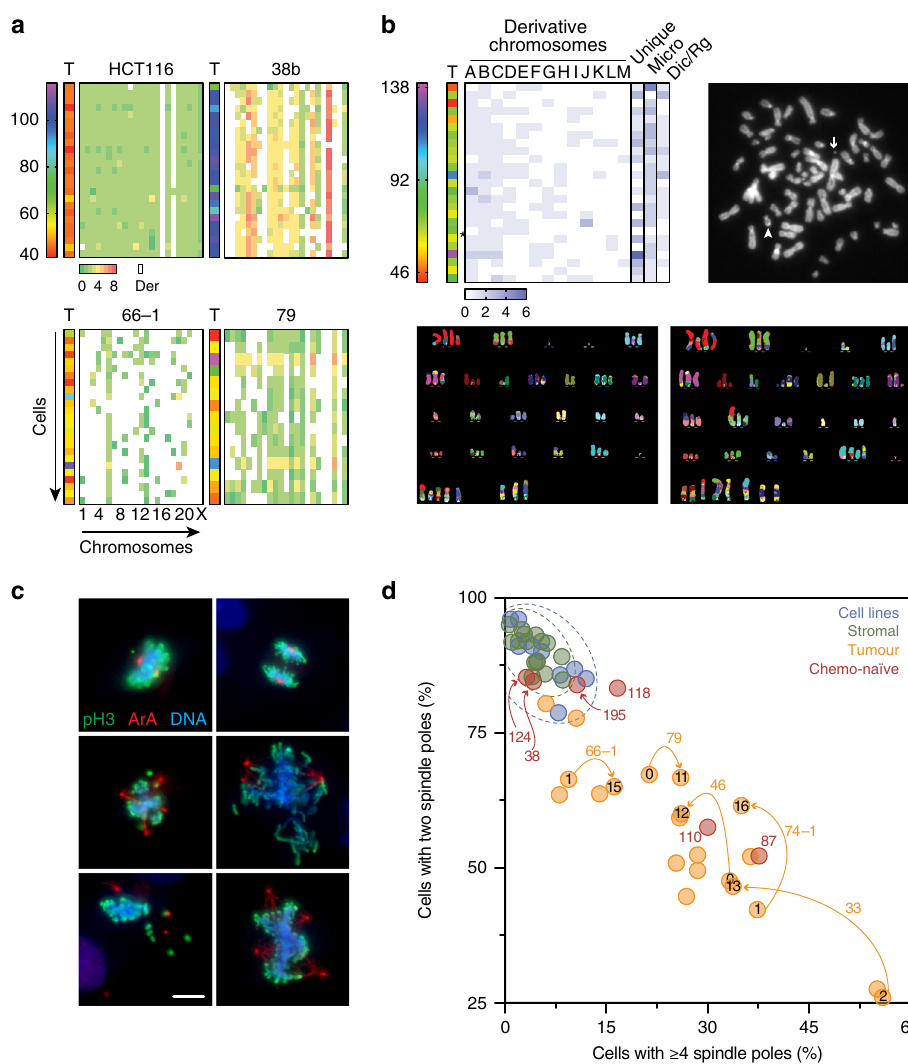
Fig. 7 M-FISH karyotyping. a Heat maps quantitating total chromosome count (T, range 40 – >100) and individual chromosome counts (matrix, range 0 – 8), for OCMs 38b, 66 – 1 and 79, enriched for tetraploidy, rearranged chromosomes and whole-chromosome aneuploidy features respectively. Derivative chromosomes indicated by white. HCT116, a near-diploid, stable cell line with two derivative chromosomes, is shown for comparison. b M-FISH analysis of OCM.59. Heat map, exemplar chromosome spread and two exemplar M-FISH images. Heat map shows total chromosome count (T) and individual chromosome counts (matrix, range 0 – 6), quantitating recurring derivatives (A to M), unique derivatives (U), DNA fragments and micro-chromosomes (Micro), and other abnormal structures including dicentrics and ring chromosomes (Dic/Rg). The chromosome spread shows a micro (arrow) and dicentric (arrowhead) chromosome while the M-FISH images show whole chromosome aneuploidies, rearranged chromosomes and different derivatives. c Immuno fl uorescence images of cells stained to detect phospho-histone H3 (serine 10), Aurora A and the DNA (representative images from single experiment). Scale bar, 10 µ m. d Quantitation of mitotic spindle poles in stromal cells, OCM tumour cells and nine established cell lines. Numbers outside the symbols indicate OCM culture while numbers inside the symbols indicate passage number. Orange arrows connect tumour samples from the same OCM culture analysed at different passages. Source data for panels a , b and d are provided as a Source Data fi